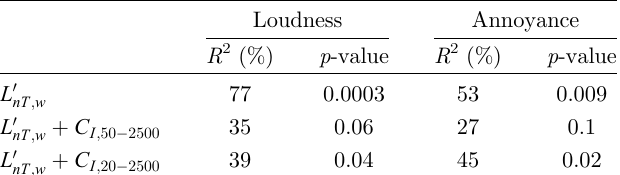
Table 4. Coef fi cients of determination of R 2 and statistical signi fi cance probability values ( p -values).